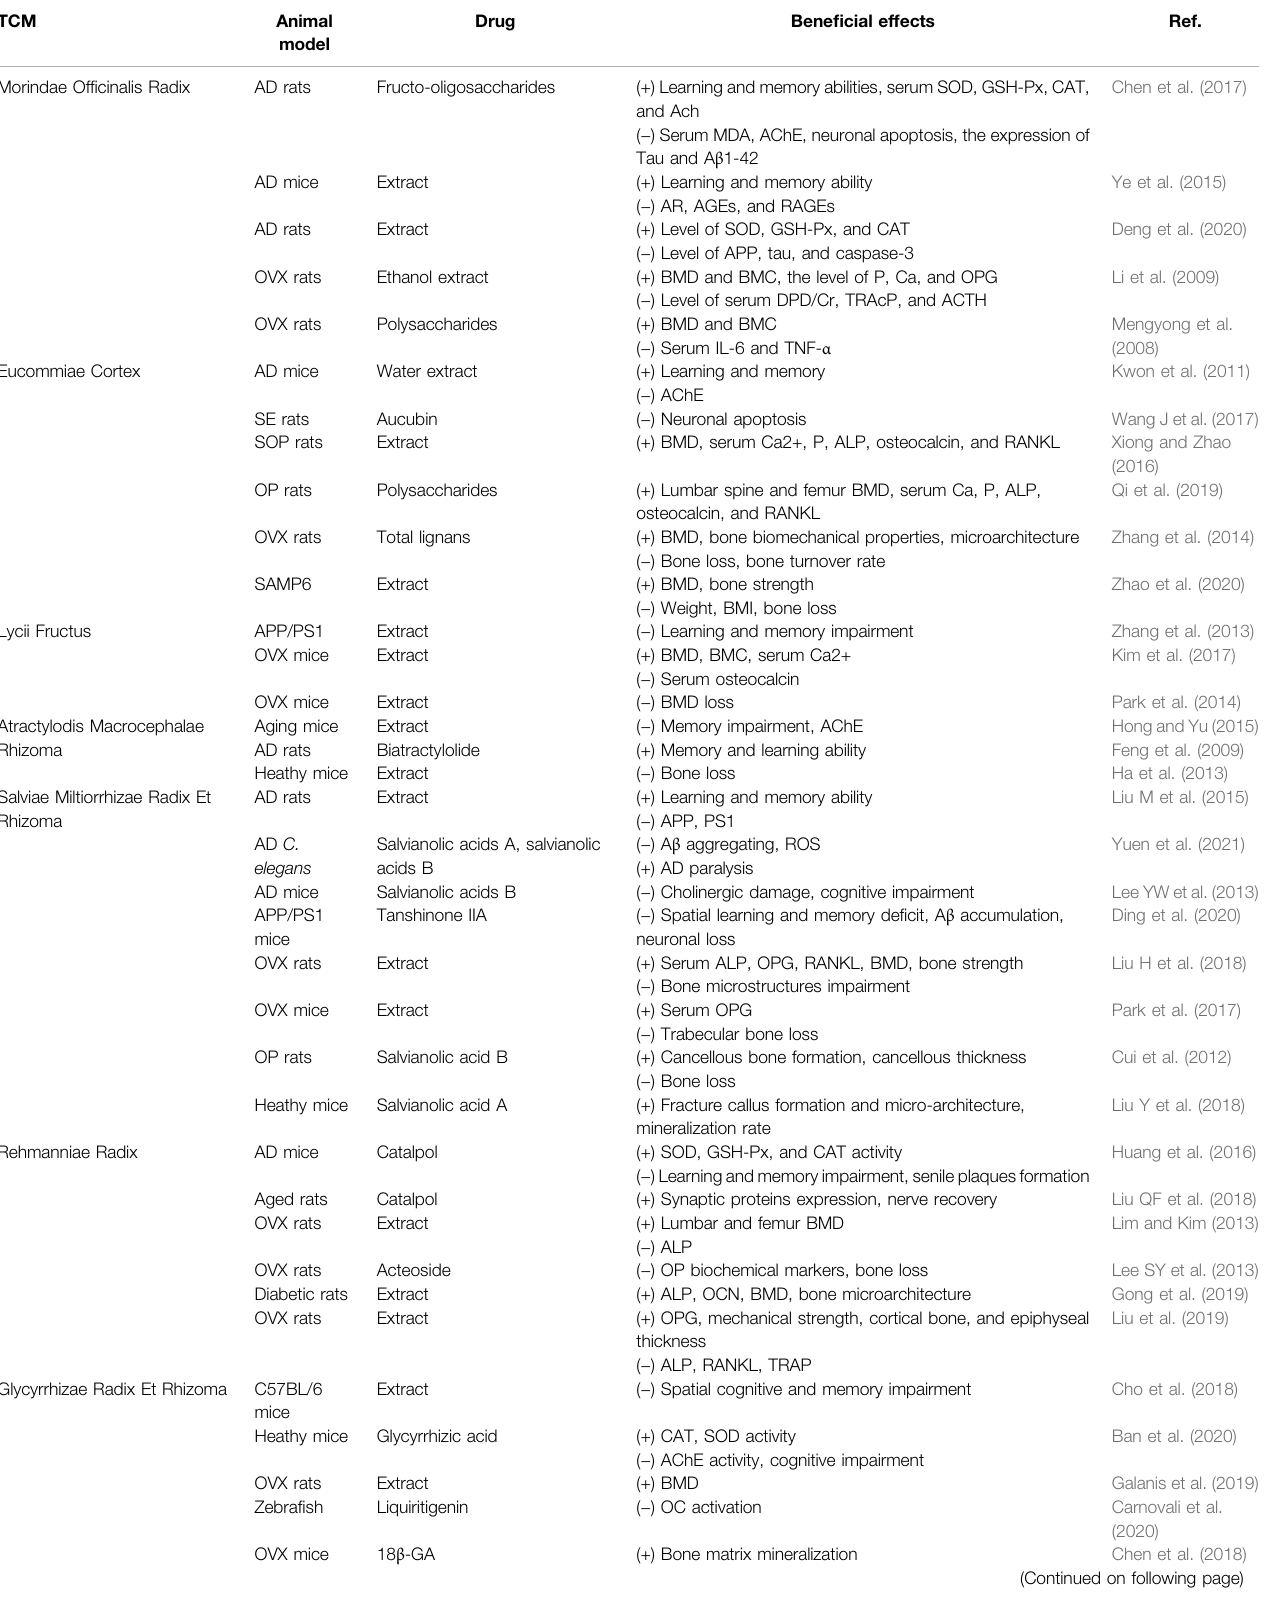
TABLE 1 | Summary of in vivo studies for the anti-Alzheimer ’ s disease and antiosteoporotic effects of natural Chinese